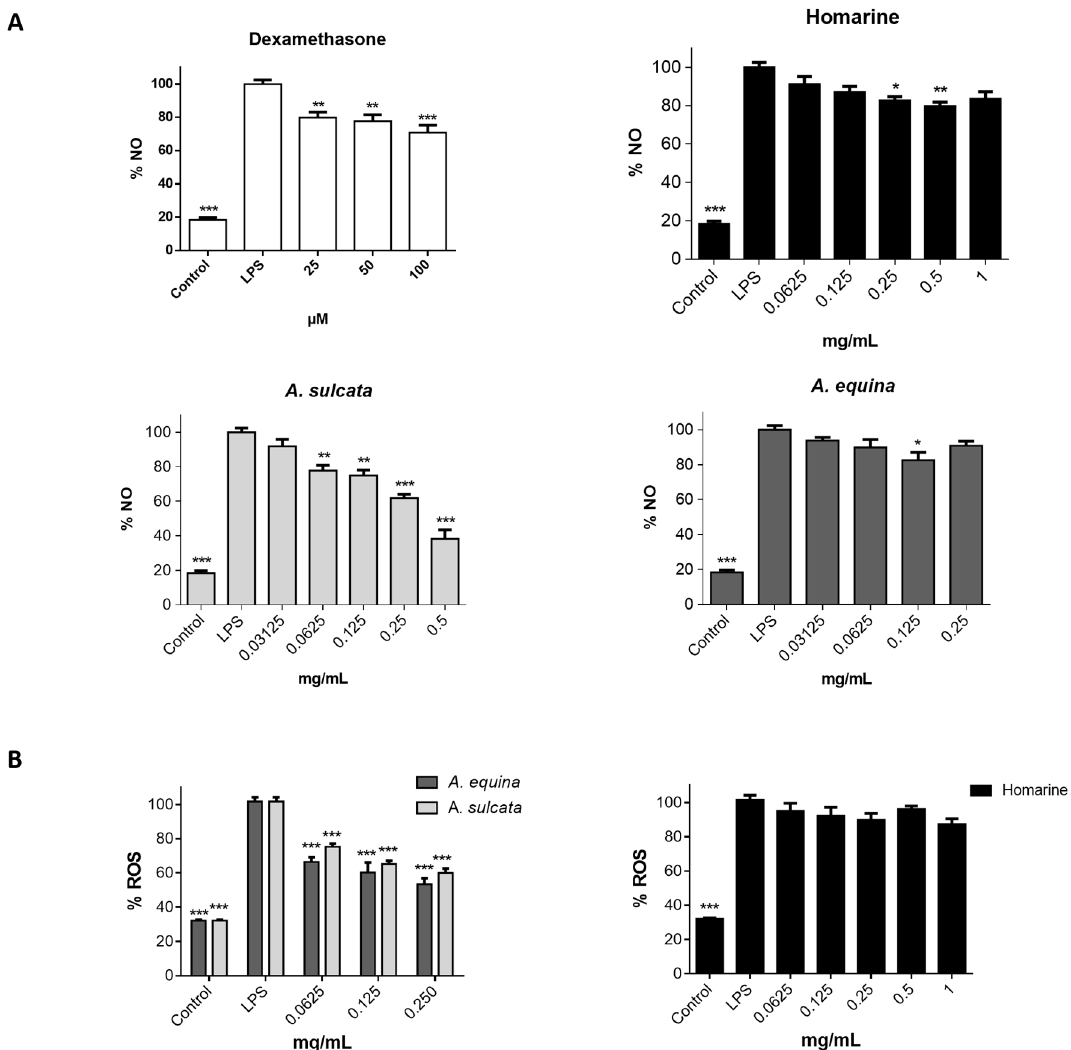
Figure 4. ( A ) Effect of both aqueous extracts, homarine and dexamethasone (positive control) on NO production by LPS-stimulated RAW 264.7 macrophages; ( B ) Effect of aqueous extracts and homarine in intracellular ROS levels of LPS-challenged cells, assessed by the fluorescent probe DCDHF-DA. Results are presented as mean ± standard error of the mean of six independent experiments performed in triplicate. Statistical significance: * p < 0.05, ** p < 0.01, *** p < 0.001.